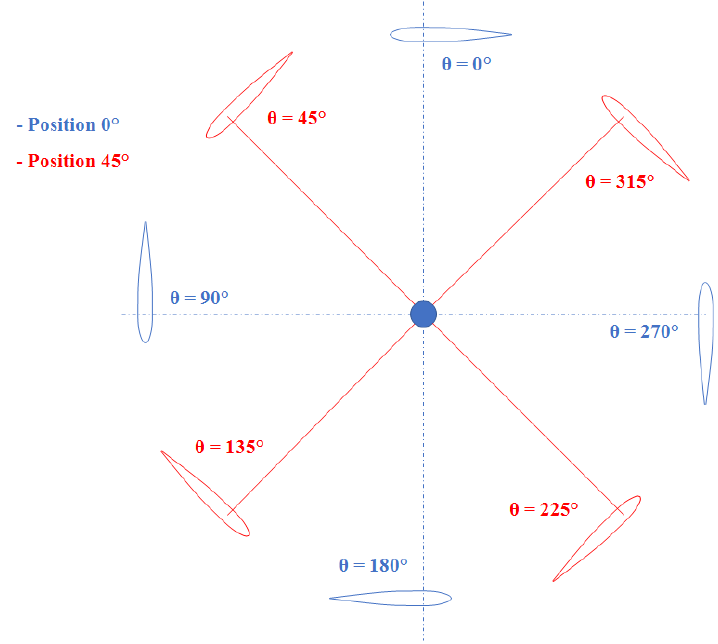
Figure 7. Azimuthal rotor position reference for the post-processing analysis.